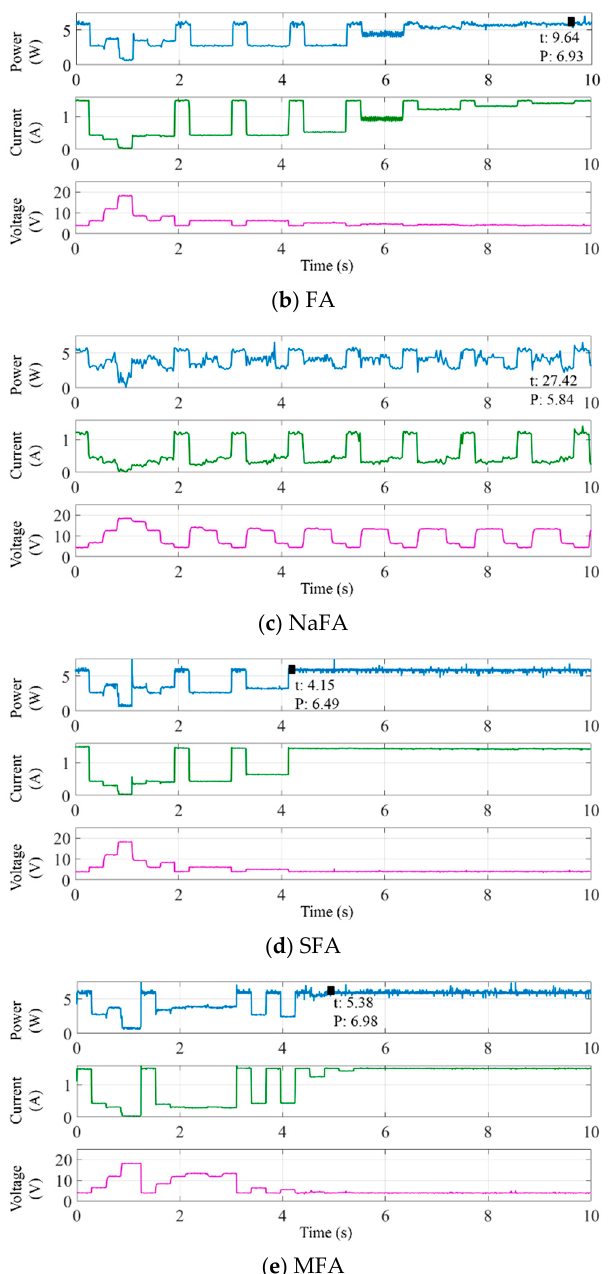
Figure 18. Power, current, and voltage variations during one evaluation tracking process of the five algorithms under Pattern #7.